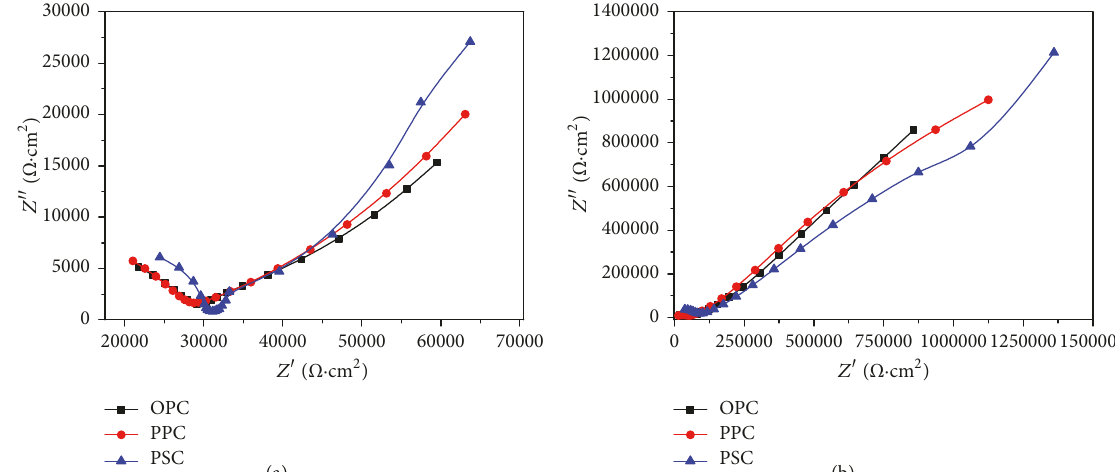
Figure9:NyquistplotsforTMTrebarembeddedinOPC,PPC,andPSCM30(a)andM40(b)gradeconcretetypes(90-daycuredspecimens).